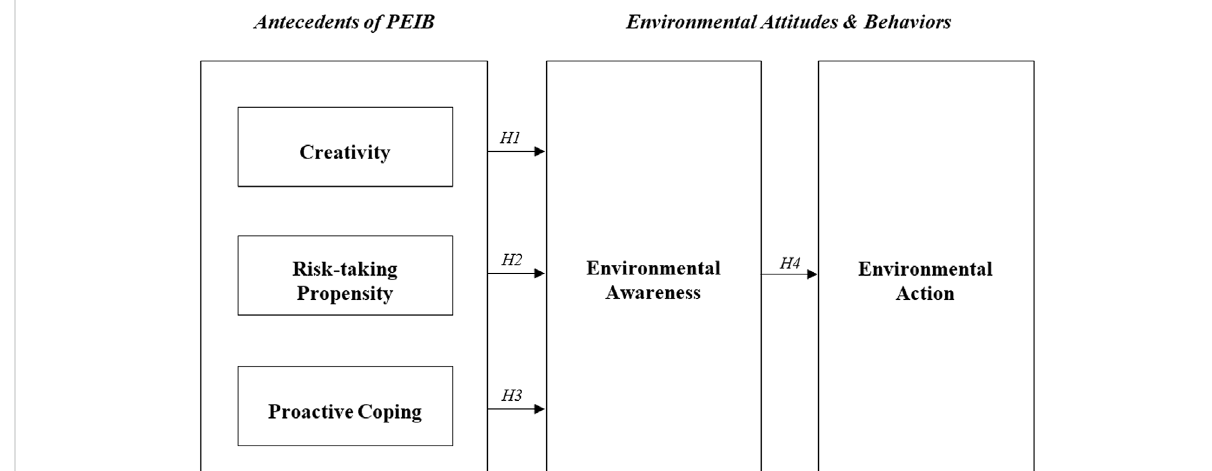
FIGURE 1 PEIB Hypotheses